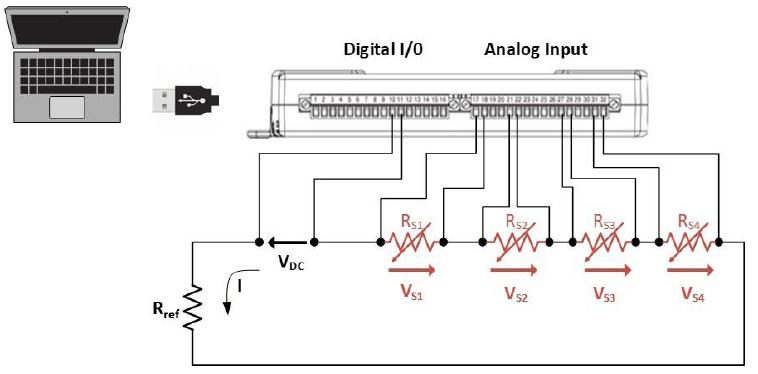
Figure 12. Diagram of connections between sensors and the DAQ. The sensors are represented by the 4 variable resistors R S 1 , R S 2 , R S 3 , R S 4 ; the voltages acquired with the acquisition board are respectively V S 1 , V S 2 , V S 3 , V S 4